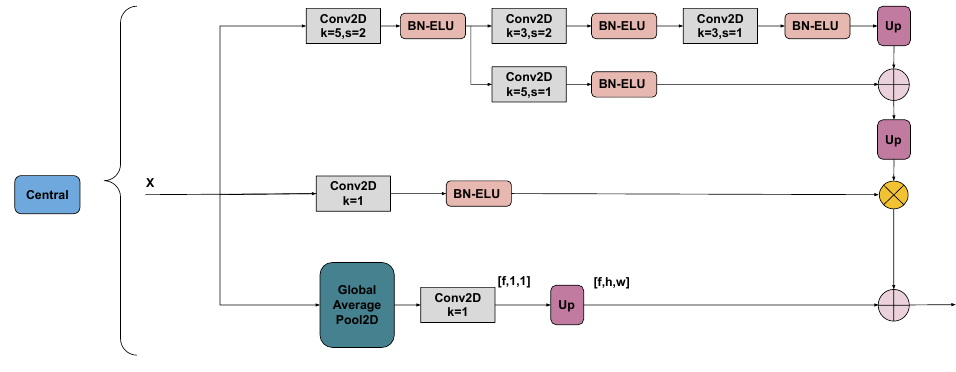
Figure 8. Central block of the